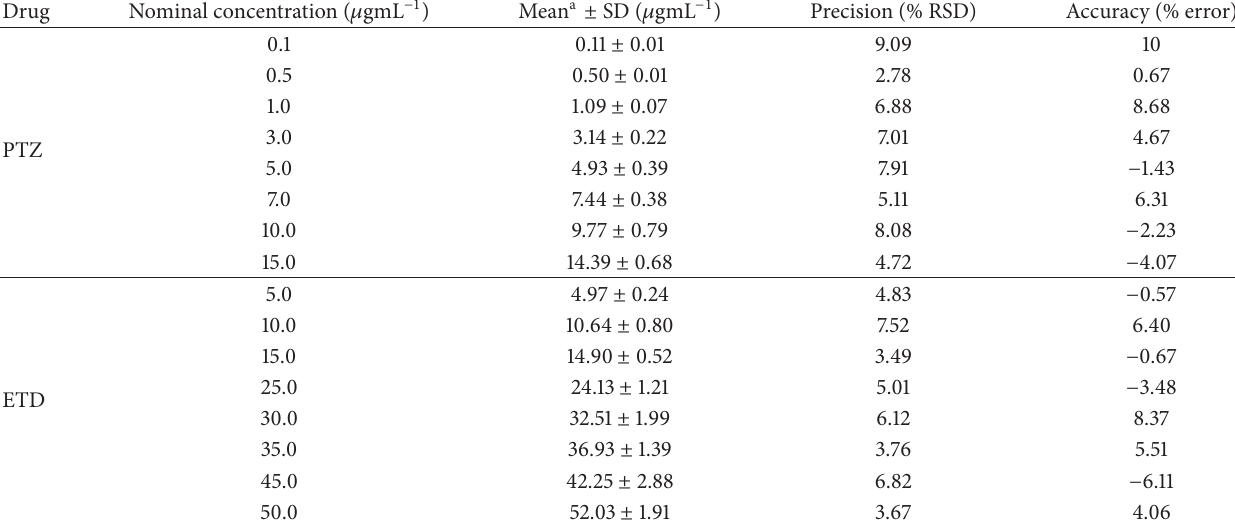
Table 2: Data of back-calculated PTZ and ETD concentrations of the calibration standards in rat plasma. Drug